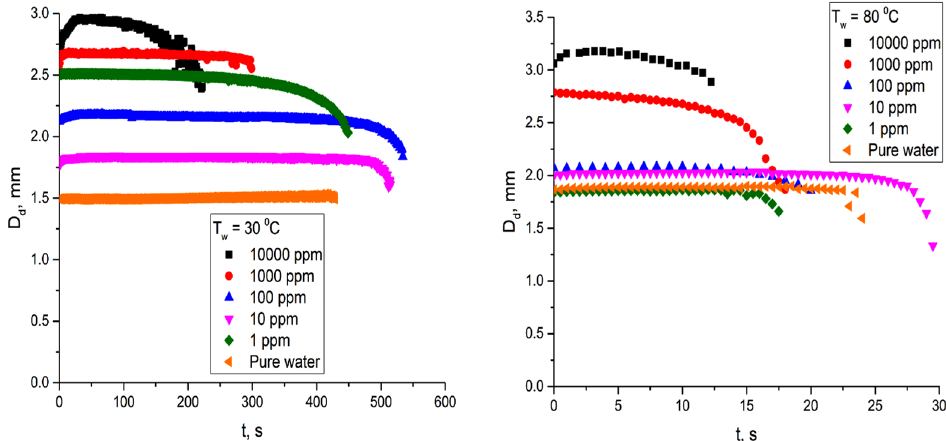
Figure 7. Evolution of dropletsdiameter over time of evaporation.